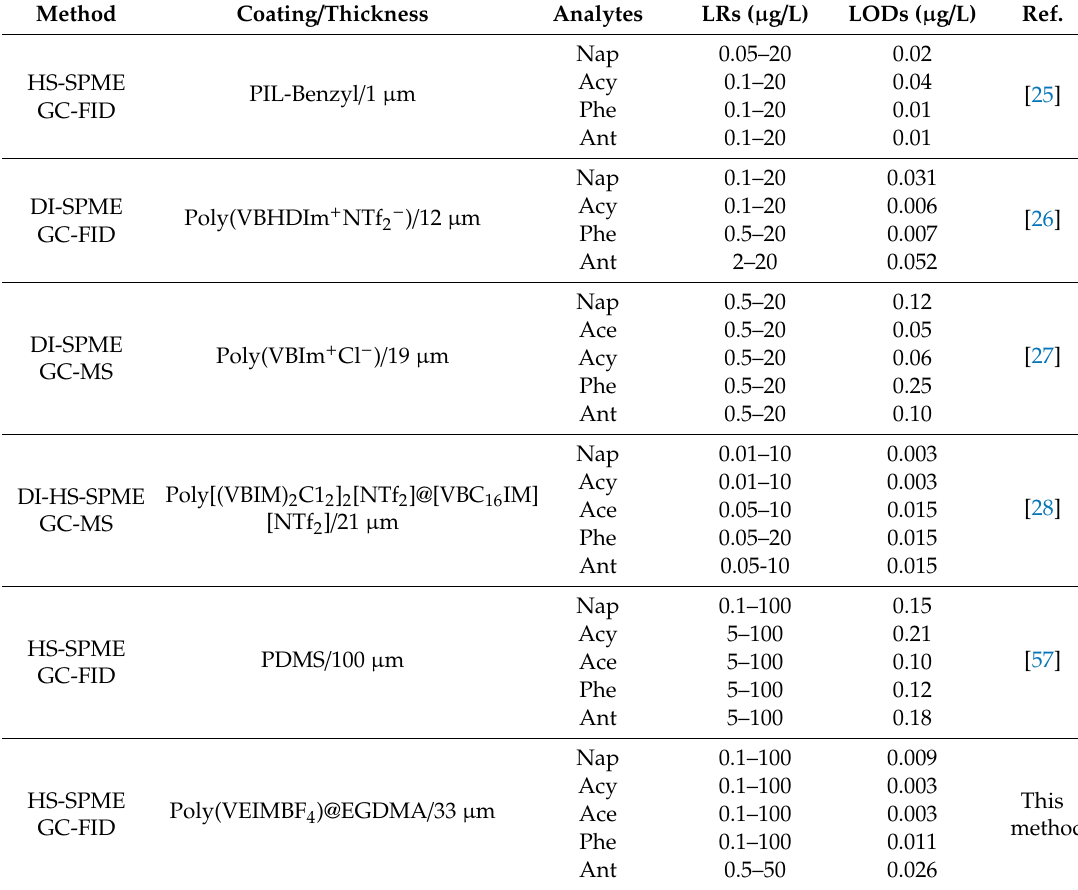
Table 1. Comparison of the developed method with other reported methods for the determination of PAHs in